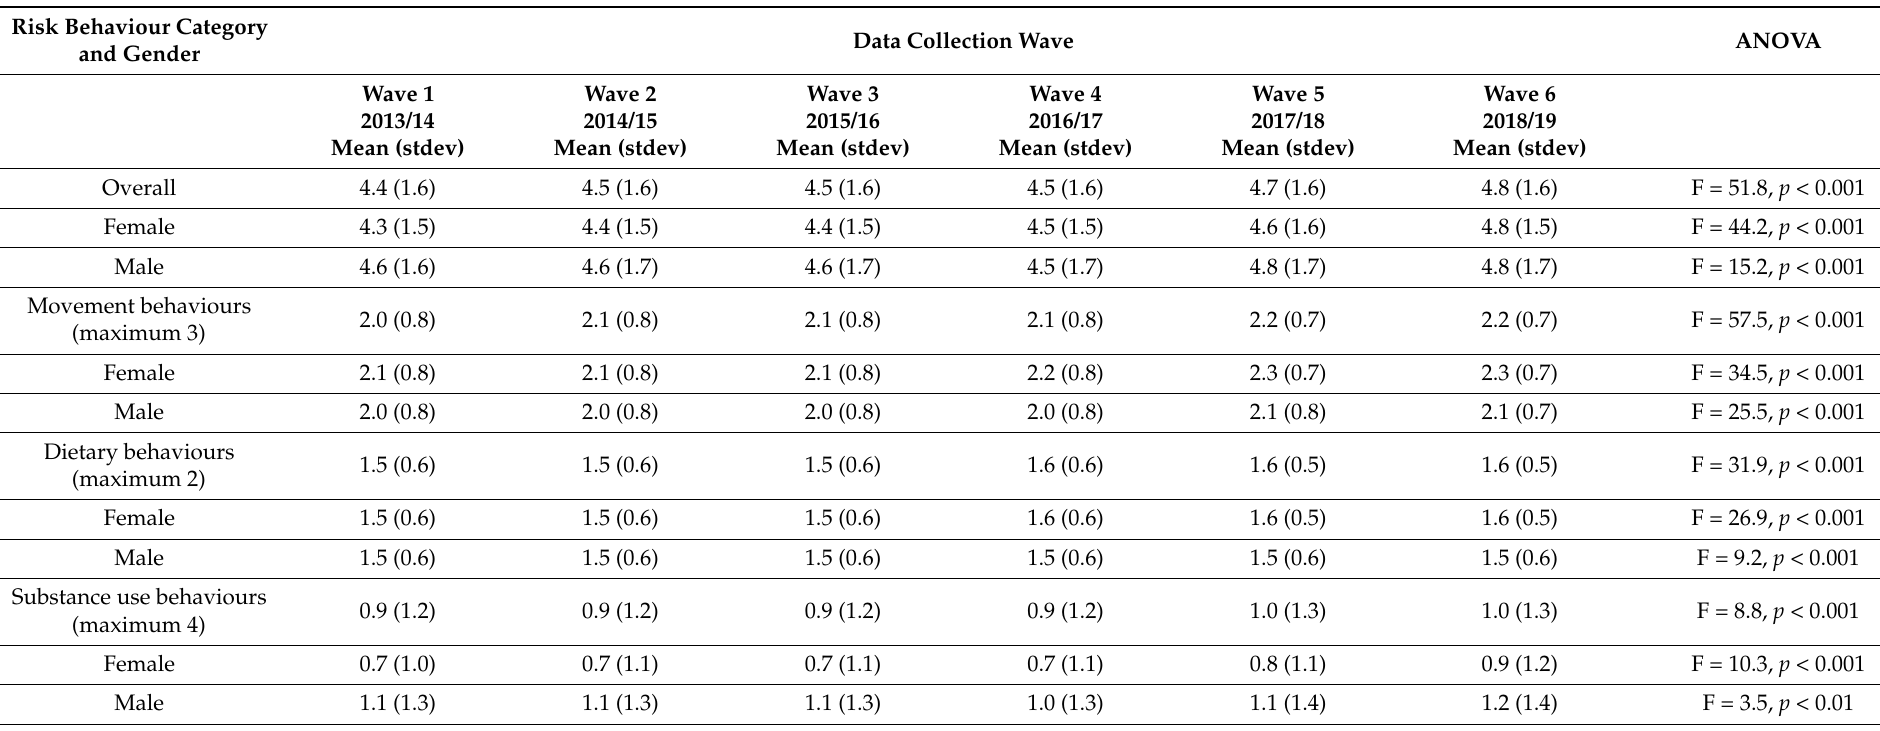
Table 2. Mean number of co-occurring health risk behaviours among grade 12 students (n = 44,740) by wave, gender, and risk behaviour category, 2013-19 COMPASS study. Risk Behaviour